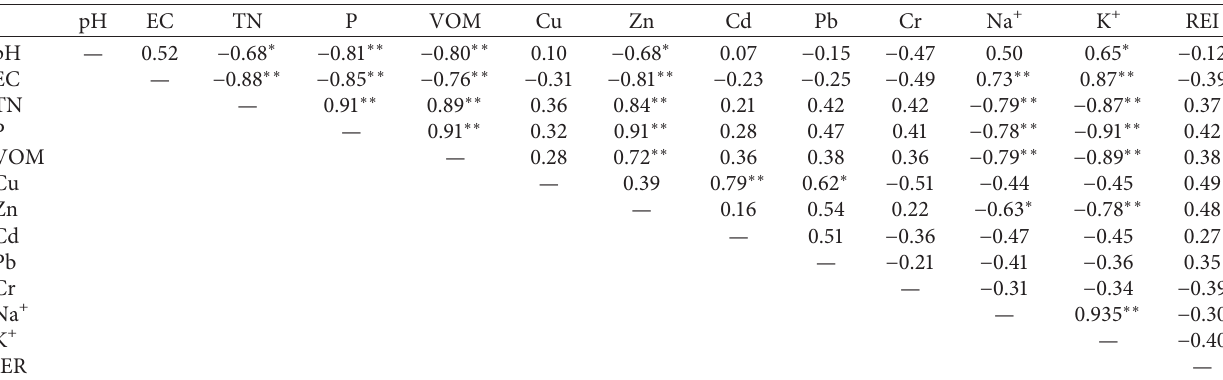
Table 2: Pearson product-moment correlation coefficients ( r ) of sewage sludge parameters.